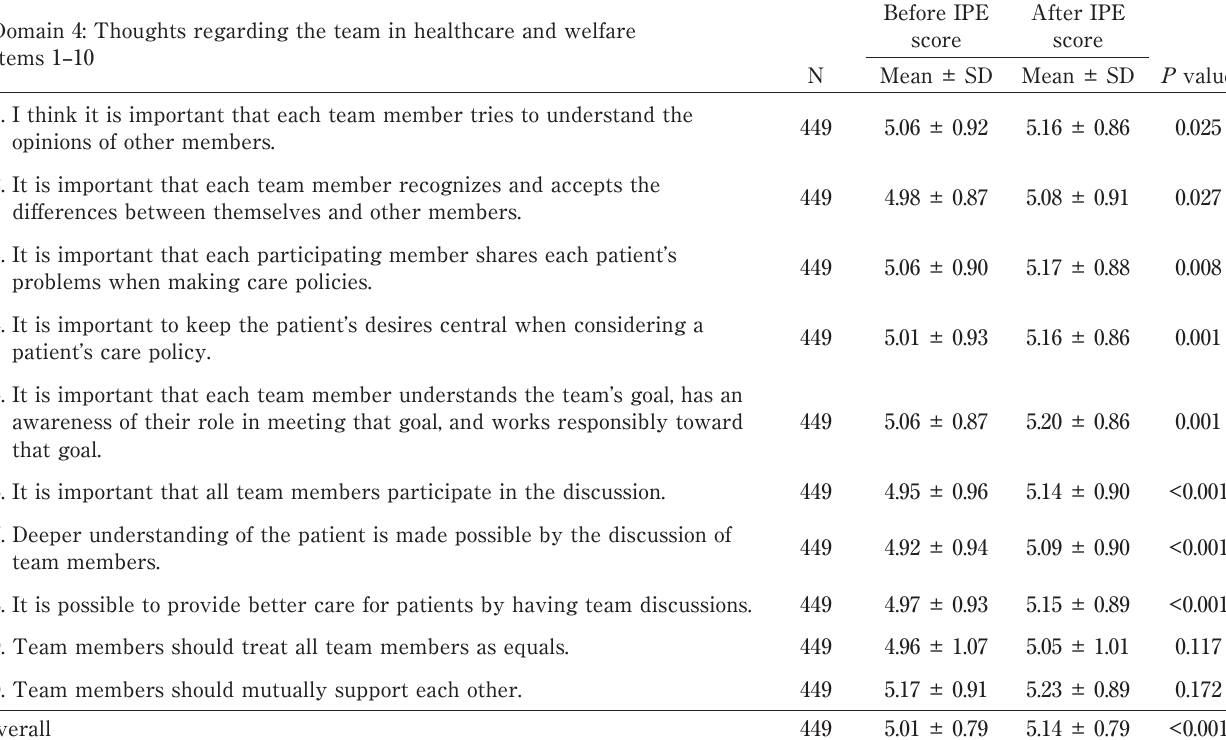
Table 5. Comparison of the scores before and after IPE in domain